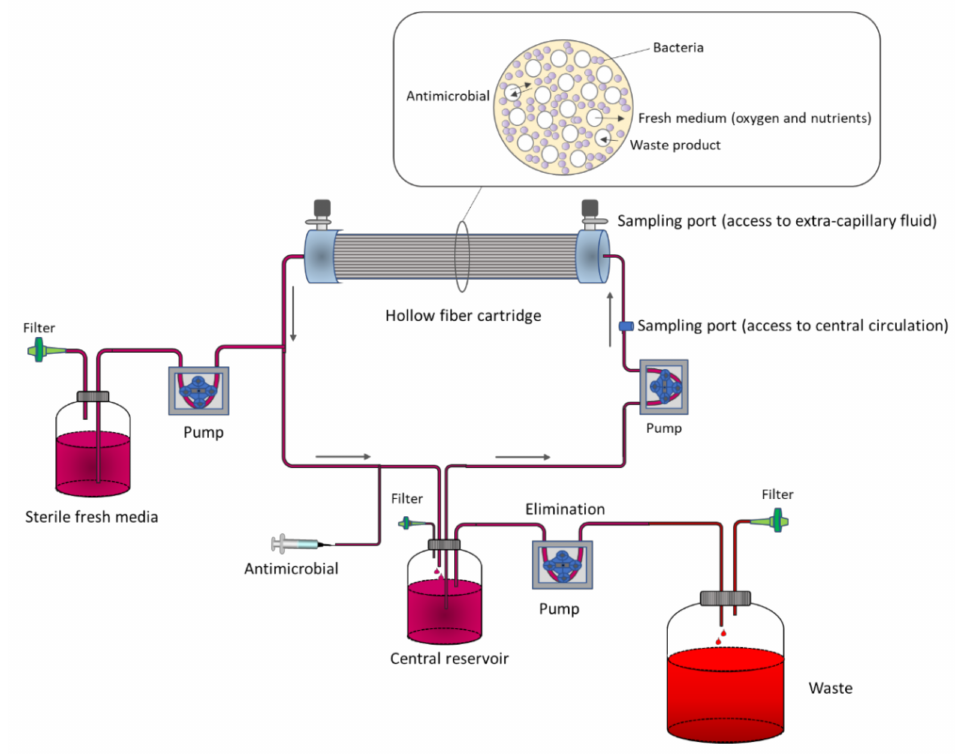
Figure 2. Representation of the hollow fiber infection model